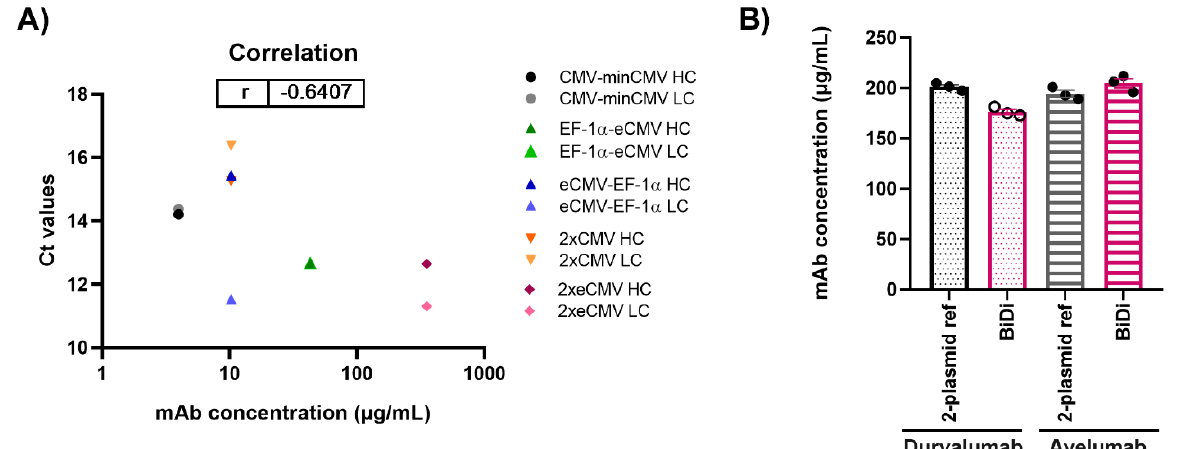
Figure 6. ( A ) Correlation of mAb concentration and Ct values for both heavy and light chain expression in Expi293-F for production of Durvalumab. ( B ) Quantification of antibody concentration for the production of Durvalumab and Avelumab using either a 2-plasmid reference or the BiDi 2xeCMV construct. Error bars represent the standard error of the mean of biological triplicates, while the symbols represent the individual measurements.